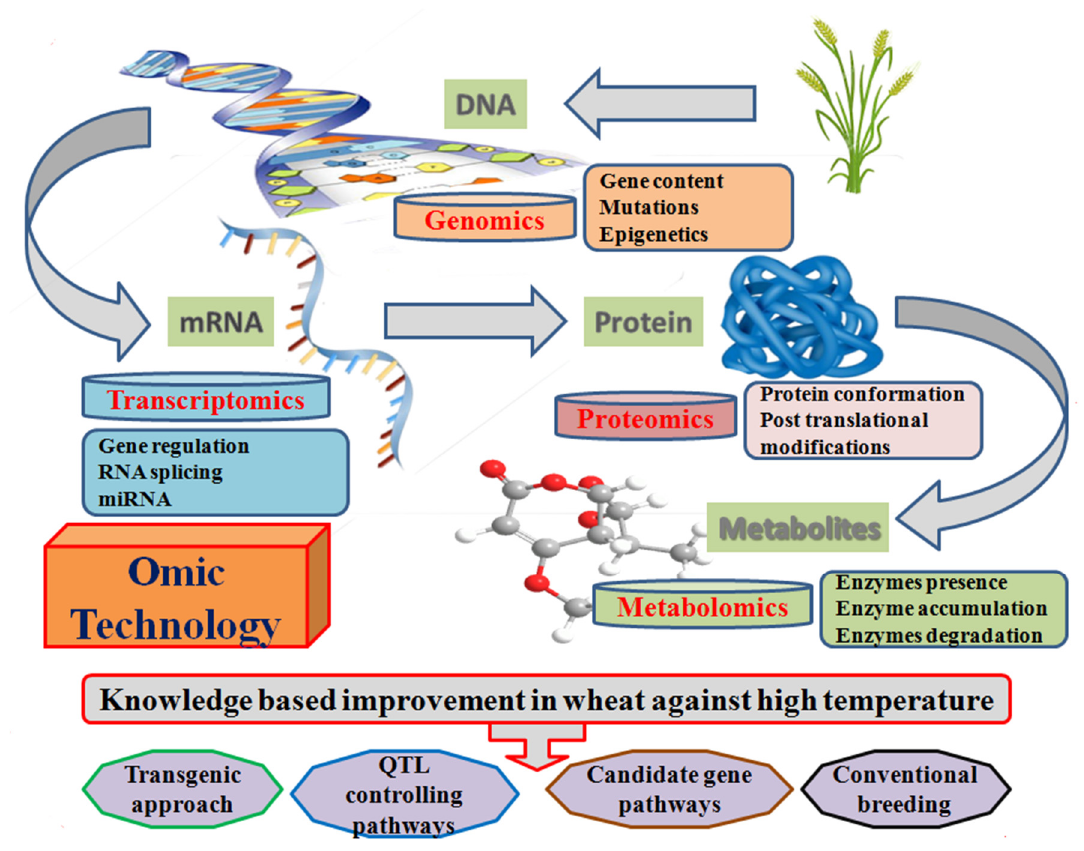
Figure 8. Schematic diagram representing the omics techniques associated with thermotolerance development in wheat at the molecular genetics level.